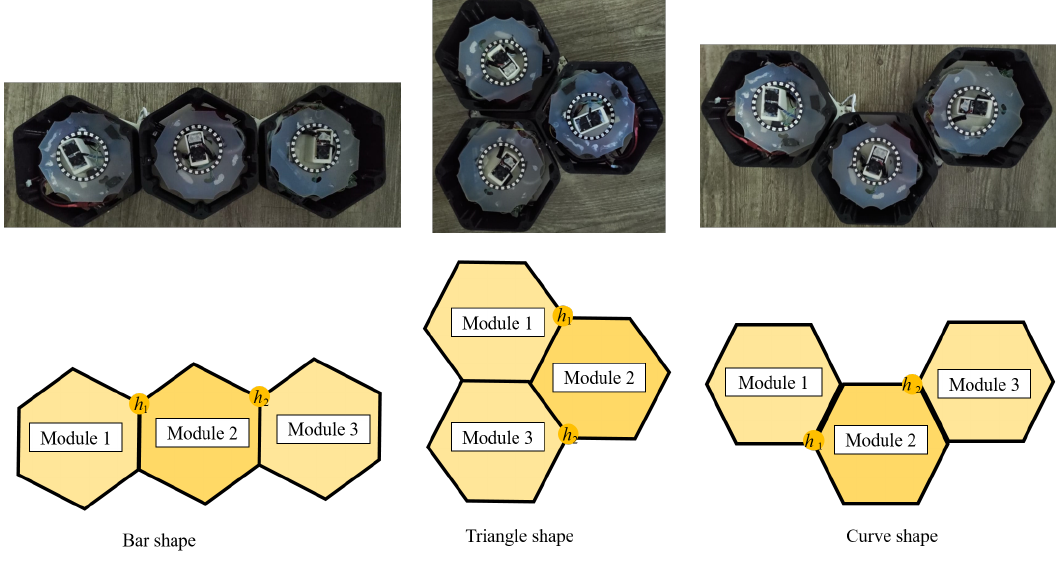
Figure 1. hTrihex reconfigurable robot with three hexagon-based